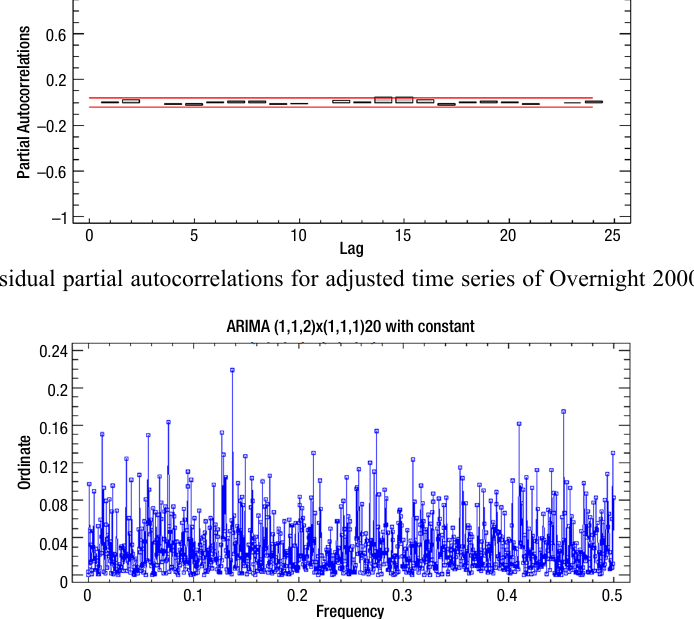
Fig. 9. Residual periodogram for adjusted time series of Overnight